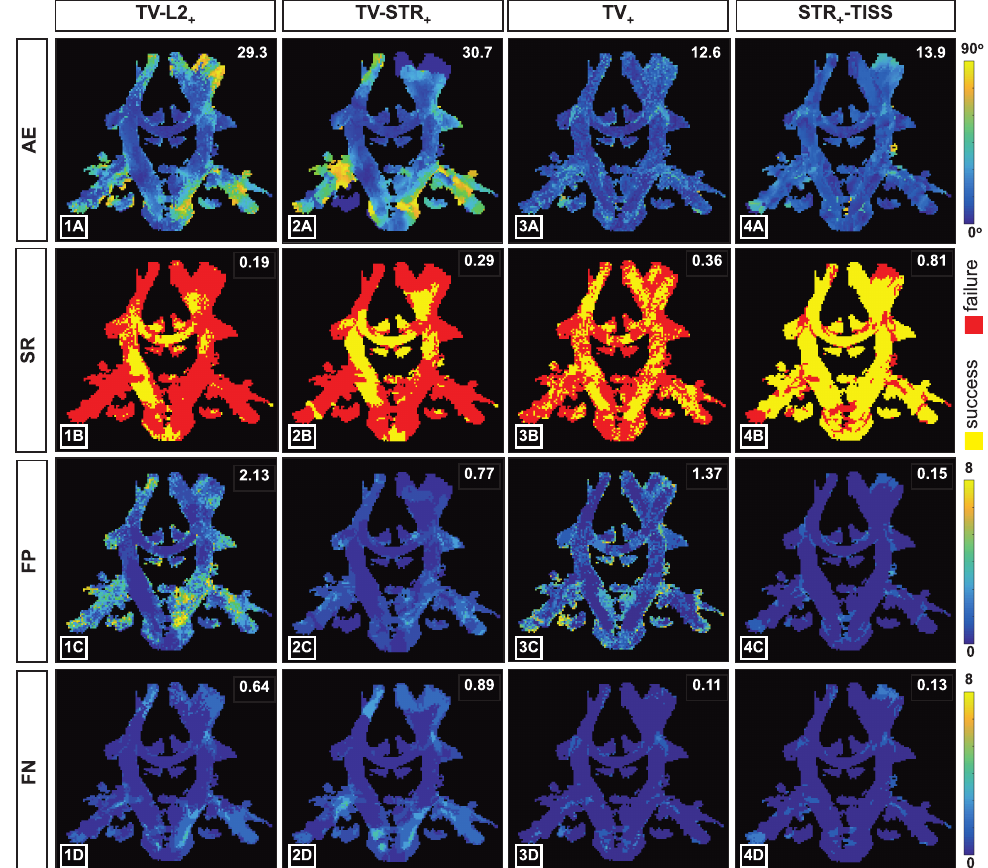
Figure 6. Visualization of the quantitative results obtained by using the four different methods described in Section 4.1, applied to the synthetic data of the ISMRM Tractography Challenge 2015. Mean angular error ( 1A – 4A ), success rate ( 1B – 4B ), false positive ( 1C – 4C ) and false negative ( 1D – 4D ) maps obtained from the reconstructions considering M = 15 q-points, with a k-space under-sampling factor N/K = 4. On the bottom right corner, values of the corresponding quantitative index are reported for the displayed